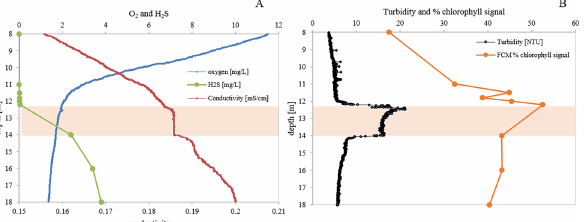
Fig 4. Physico-chemical and biological profiles of Lake Cadagno water column. A) Oxygen [mg L -1 ], H 2 S [mg L -1 ], conductivity[mS cm -1 ]. (B) Flow cytometry detected percentageof microbialchlorophyll and bacteriochlorophyll(% red fluorescence, FL3 positive-signal) and turbidity profile [NTU]. Orange shading highlightthe chemoclinelayer on the samplingday (12 July